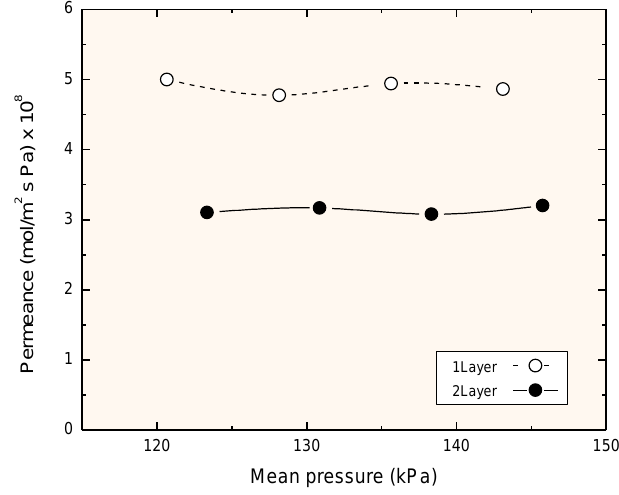
Figure 3. Nitrogen permeation at room temperature.